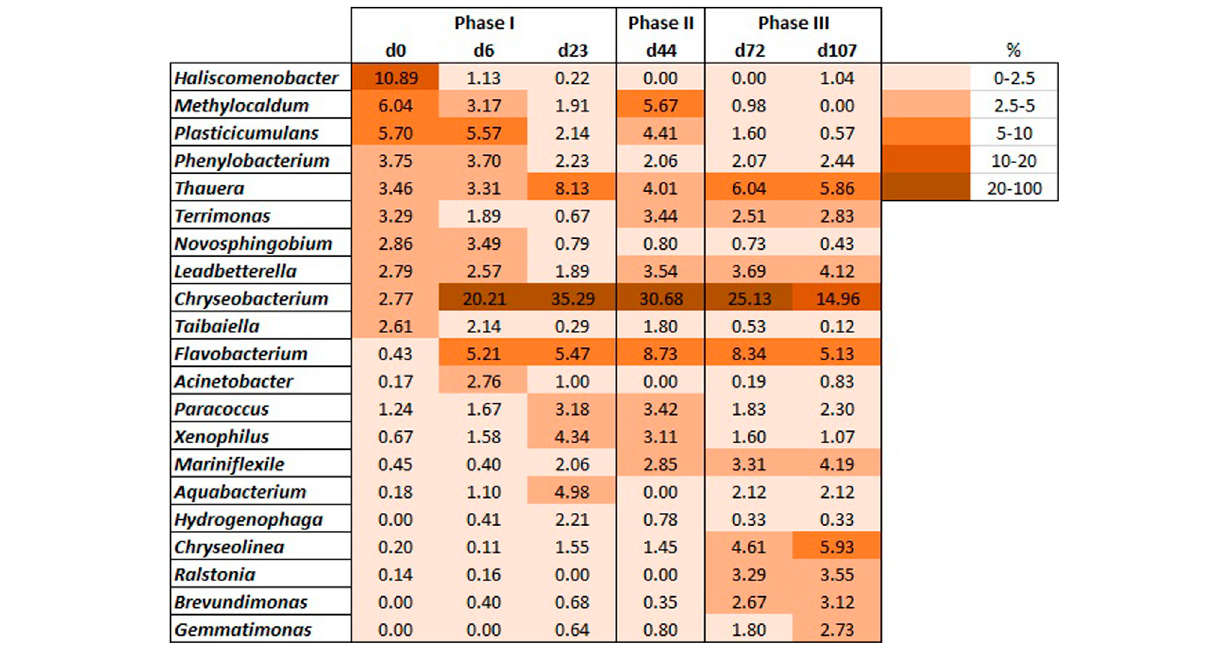
Frontiers in Environmental Science |